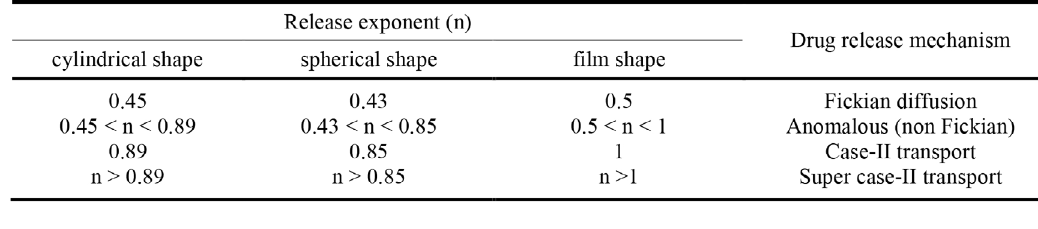
Table 2. Release exponent and mechanism for polymeric